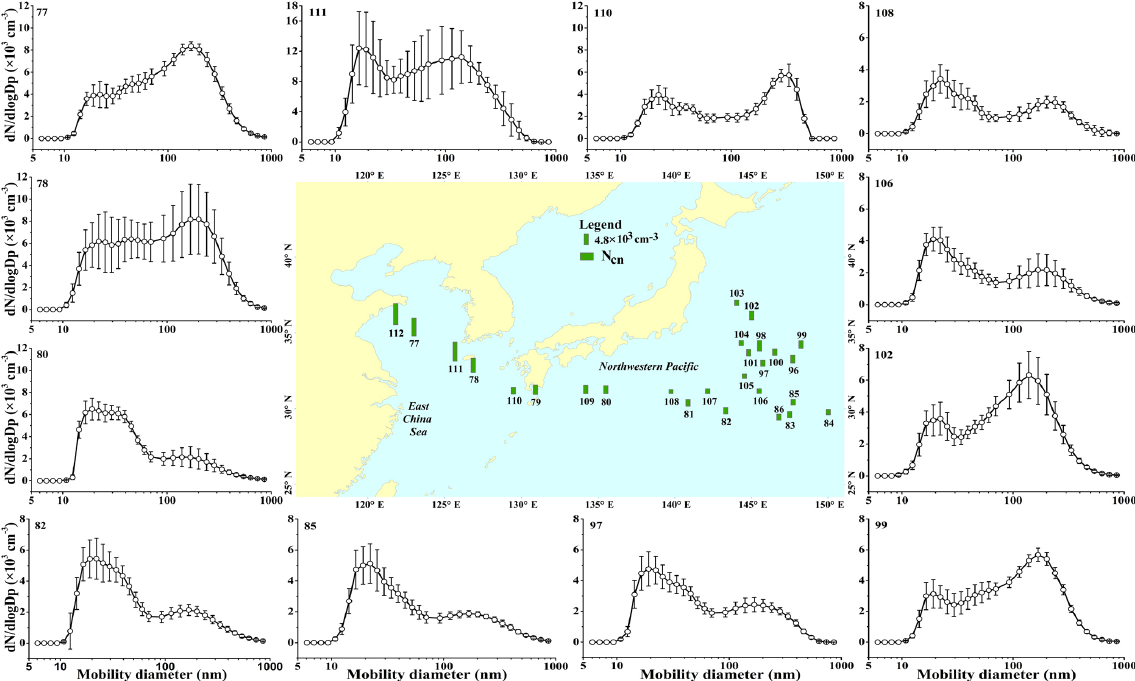
Figure 1. Geographical distributions of daily N cn and number size distribution of aerosol particles measured over the NWPO during DOY 77–112, 2014. The entire cruise was divided into five periods, including departure and return periods (77–80, 109–112), Period 1 (81–86), Period 2 (87–97), Period 3 (98–102), and Period 4 (103–108). For each period, the mode distribution is relatively comparable; thus, only a few days were selected to show the number size distributions, with the cruise day showing on the top left, corresponding to the number in the middle